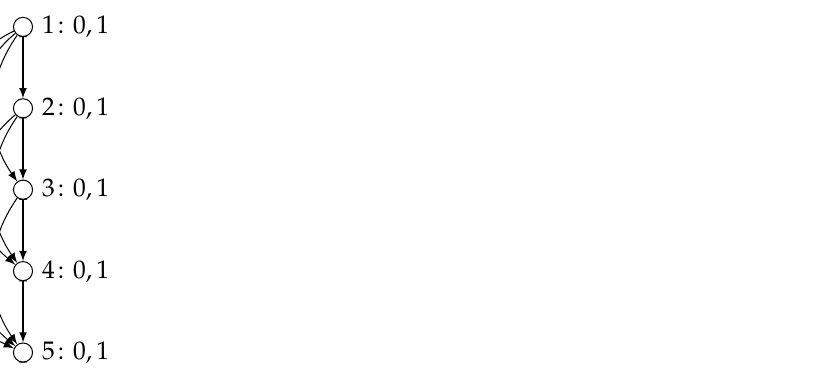
Figure 7. Extensive-form game of perfect information illustrating Proposition 4. for every 0 we have n denote the vector ( n , n , n , n , n ) T .